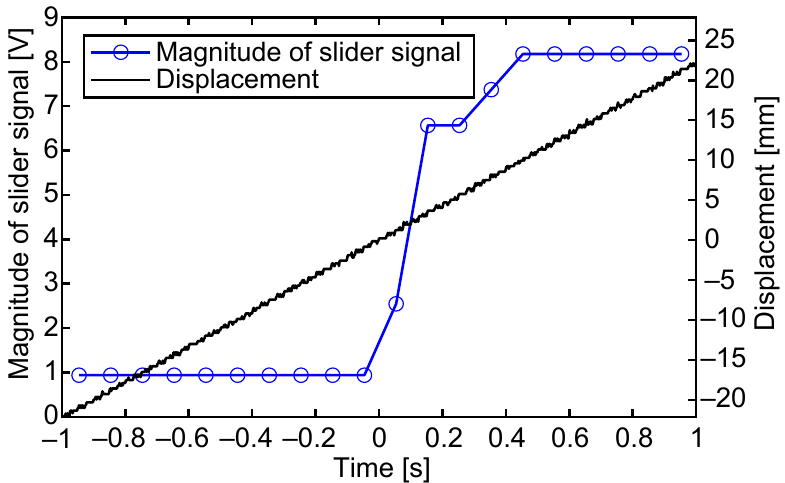
Figure 18. The magnitude of the slider signal when the slider is driven towards and over the sensing electrode. The edge of the slider reached the sensing electrode at 0